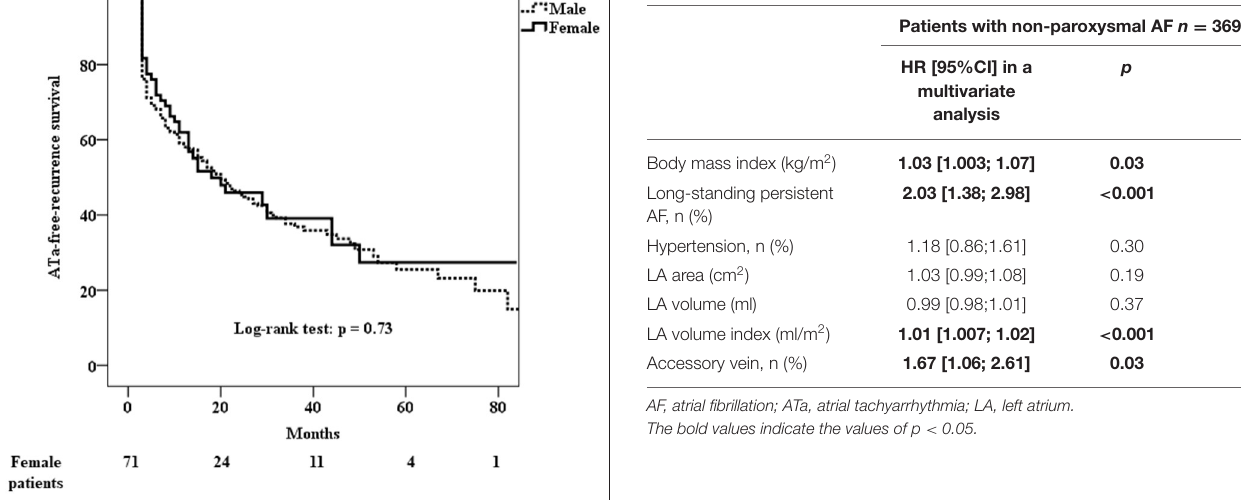
TABLE 6 | Predictive factors (multivariate analysis) of ATa recurrence after index cryo-PVI for non-paroxysmal